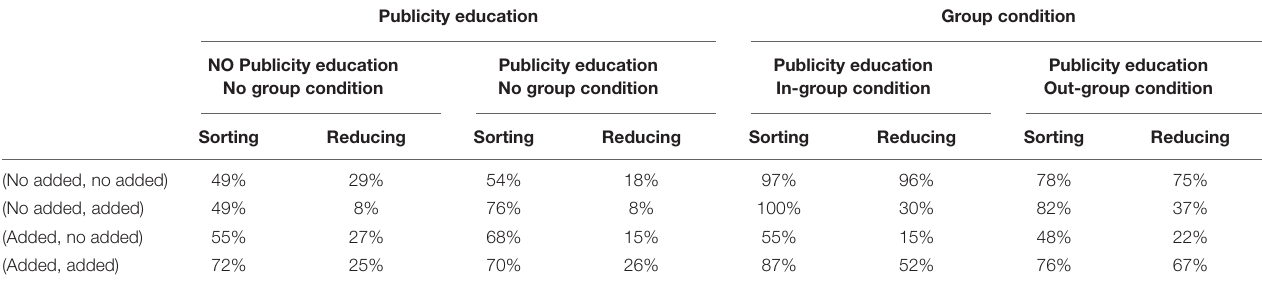
TABLE 13 | Probability distribution of PEBs under income changes, publicity education, and group